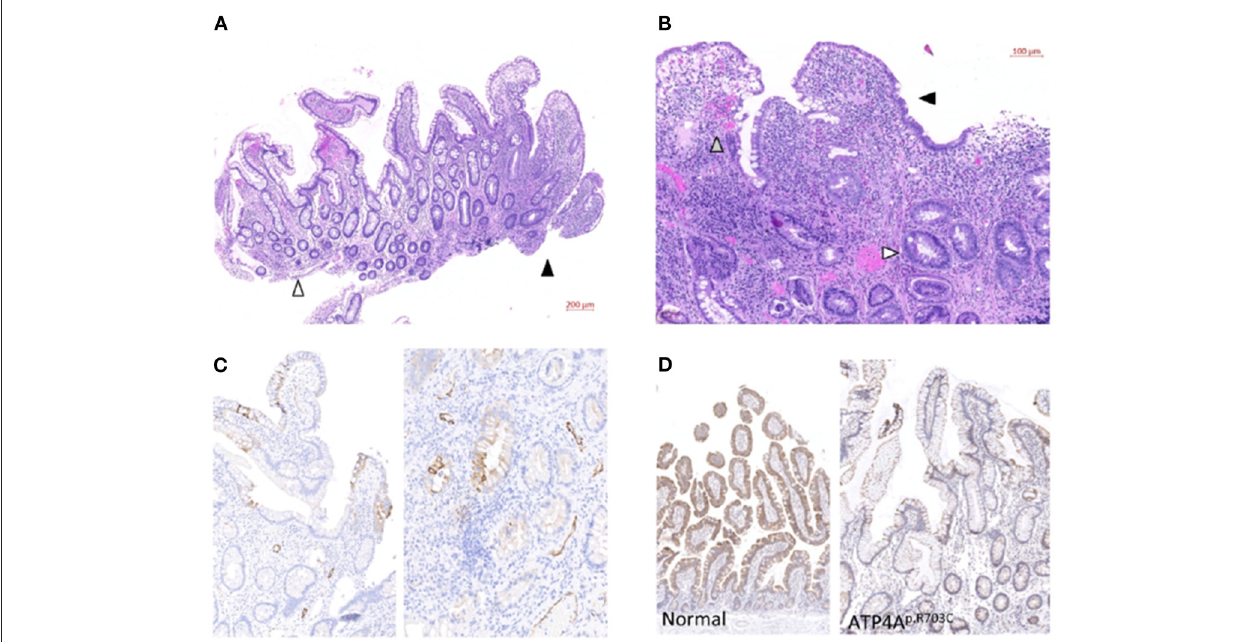
FIGURE 3 | Clinicopathologic evaluation of the patient. (A) Representative H&E staining of 2019 ileum biopsy. White arrowhead: moderate microvilli atrophy in normal intestinal tissue of the patient. Black arrowhead: severe inflammation process in a biopsied aphthous ulcer. Scale bar: 200 µ m. (B) Detailed evaluation of inflamed area shows atrophic and flattened microvilli with strong reduction of goblet cells (black arrowhead) and oedema and cryptitis (gray arrowhead). Reactive glands (white arrowhead) and inflammatory infiltrate with abundant neutrophils and eosinophils are observed in the whole mucosa. Scale bar: 100 µ m. (C) Two different representative areas of the 2019 patient intestine biopsy stained with anti-cytokeratin7 antibody. Scale bar: 100 µ m. (D) Representative immunohistochemical staining with anti-Pyruvate Carboxylase antibody of a normal intestine (left) and the 2019 patient biopsy (right). Reduced staining signal in the patient correlates with altered mitochondrial function. Scale bar: 100 µ m.